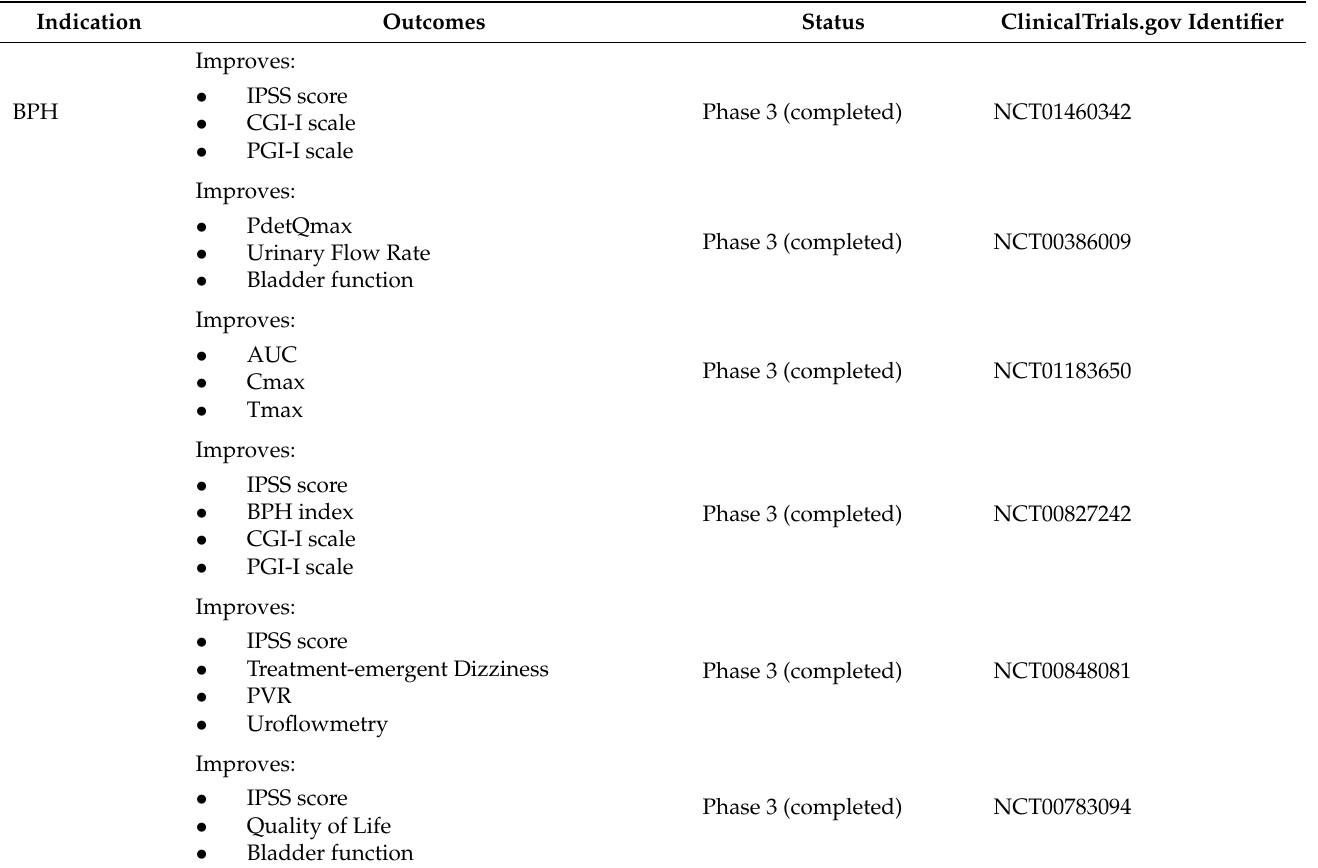
Table 2. List of studies on PDE5 inhibitor tadalafil, benign prostatic hyperplasia and cancer at www.clinicaltrials.gov (accessed on 30 March